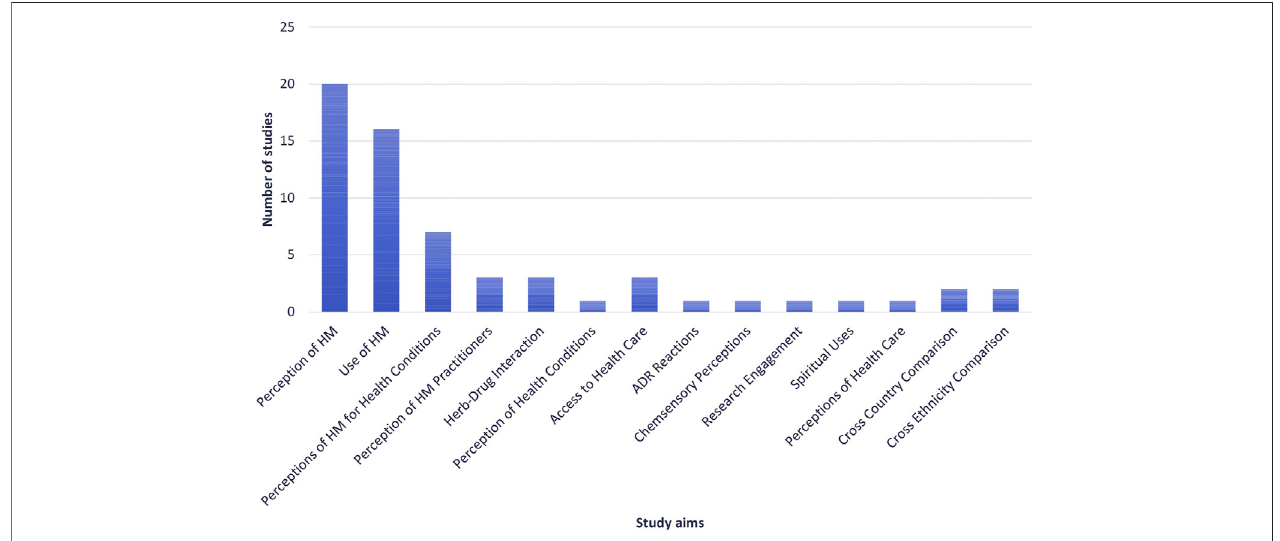
FIGURE 2 | Number of studies allocated to each of the identi fi ed study aims. ADR: adverse drug reaction, HM: herbal medicine.